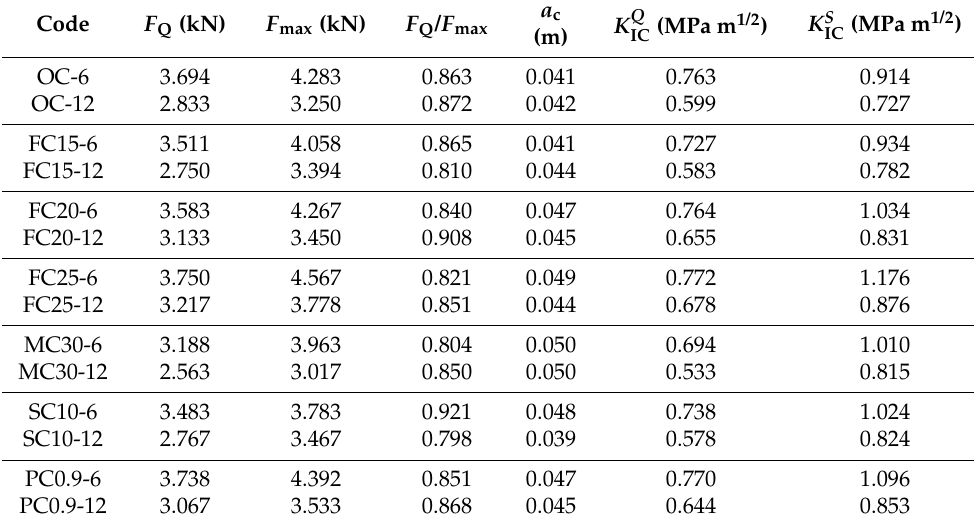
Table 7. Fracture toughness of modified concrete exposed to 6 and 12 dry–wet